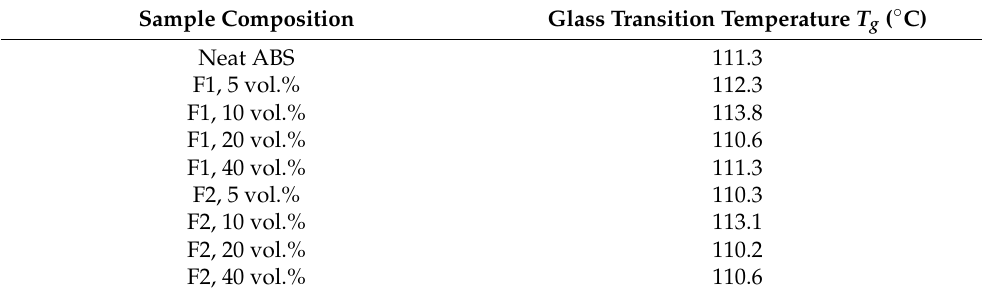
Table 2. The glass transition temperature ( T g ) for neat ABS and samples with different ABS–filler compositions.